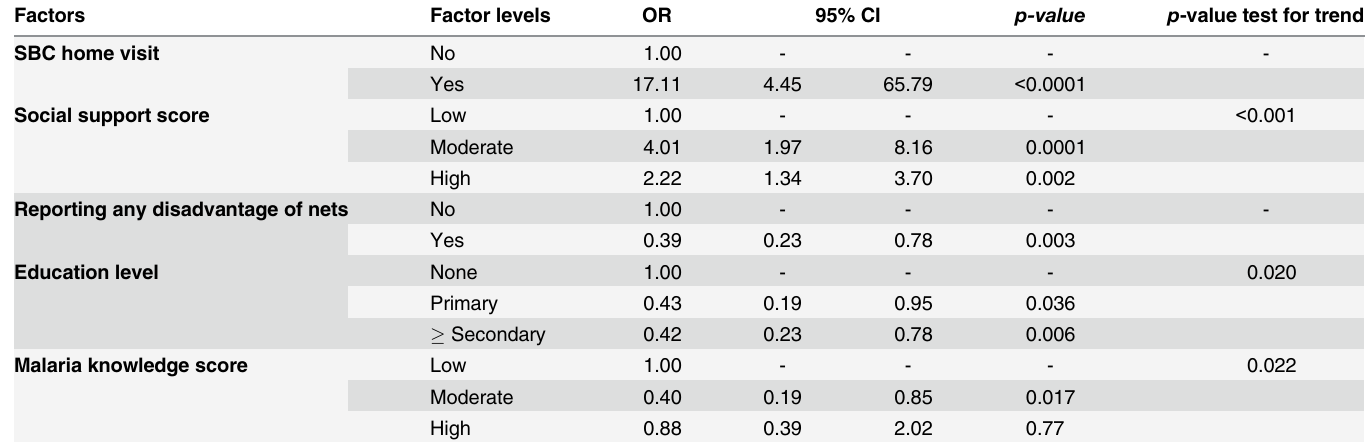
Table 4. Multivariable logistic regression analysis of association between individual net use and explanatory factors, controlling for net density, among respondents living in households owning at least one net, Ebonyi state, Nigeria. SBC: social behavior change